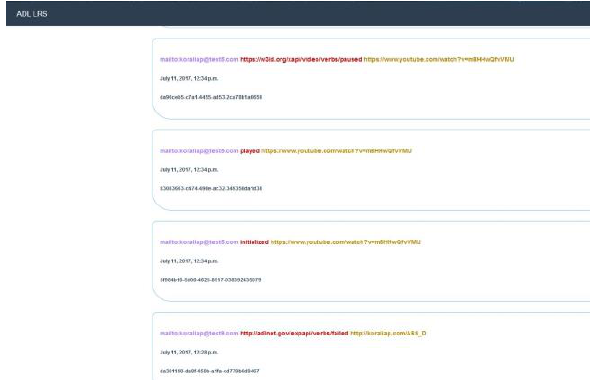
Figure 7. If the user has not completed Course 1, he watches the slides concerning relevant content.